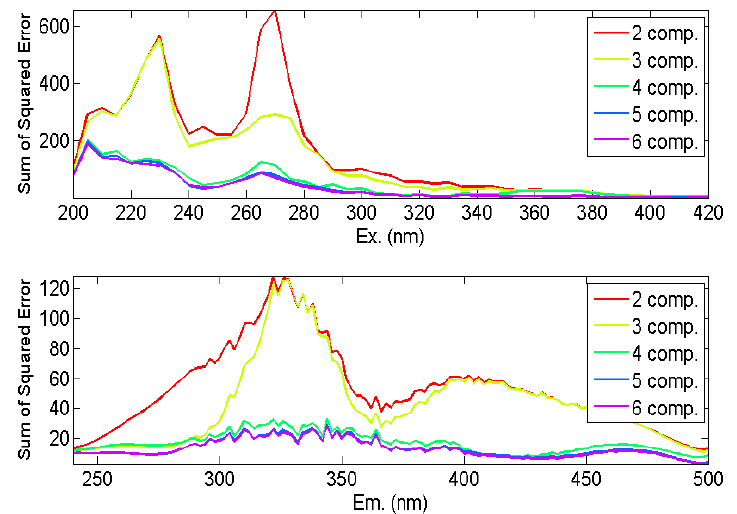
Figure 5. The sum of squared error of the excitation spectrum and emission spectra.